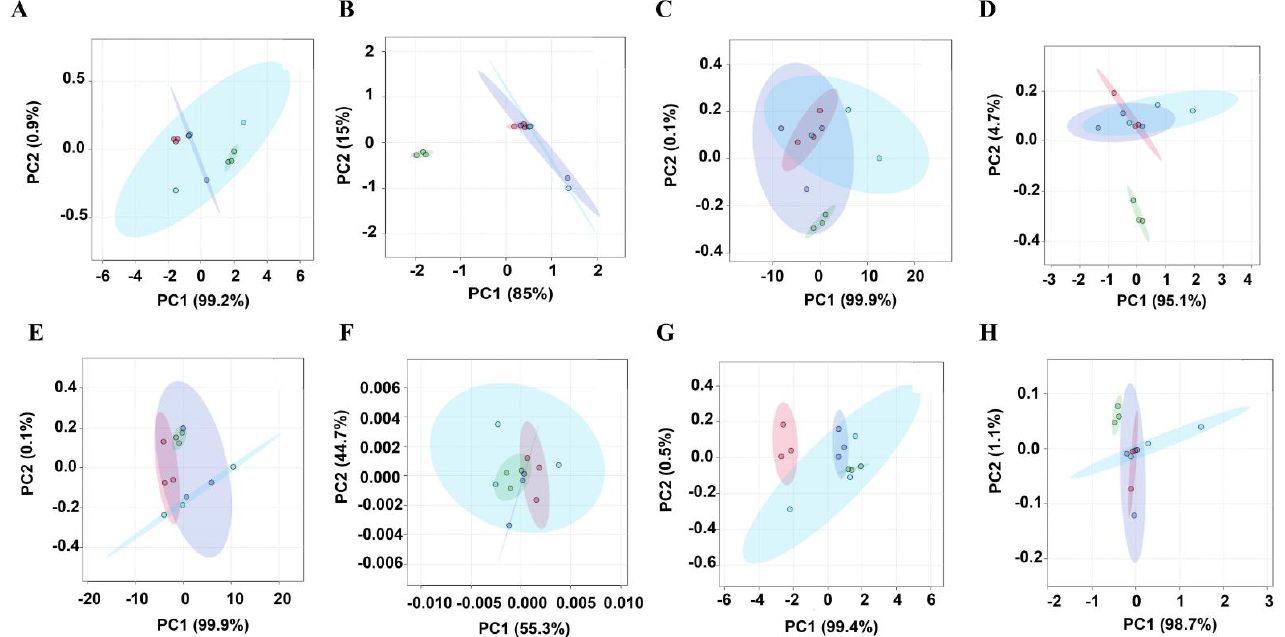
Figure 1. Identification of individual taste differences in meat from four livestock species using an e-tongue. In the picture, green represents chicken, purple represents duck, blue represents pork, and pink represents beef. Differences in umami ( A ), umami richness ( B ), bitterness ( C ), bitterness aftertaste ( D ), sourness ( E ), saltiness ( F ), astringency ( G ), and astringency aftertaste ( H ) were identified for the four animal species, respectively.